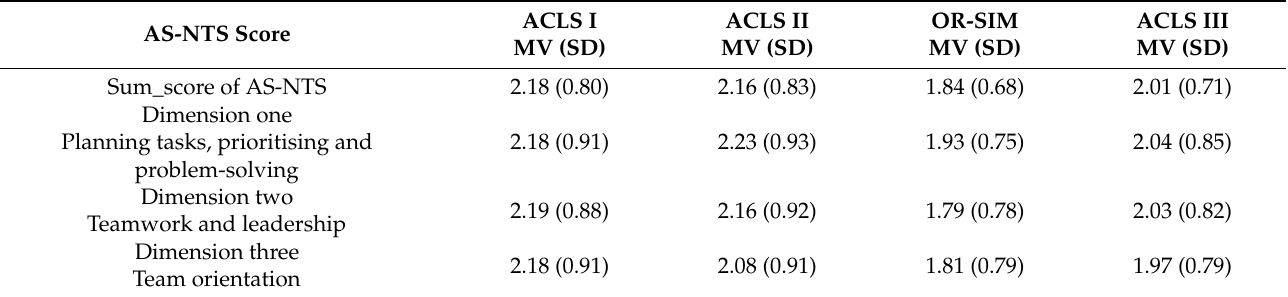
Table 2. Overall NTS performance of all students.